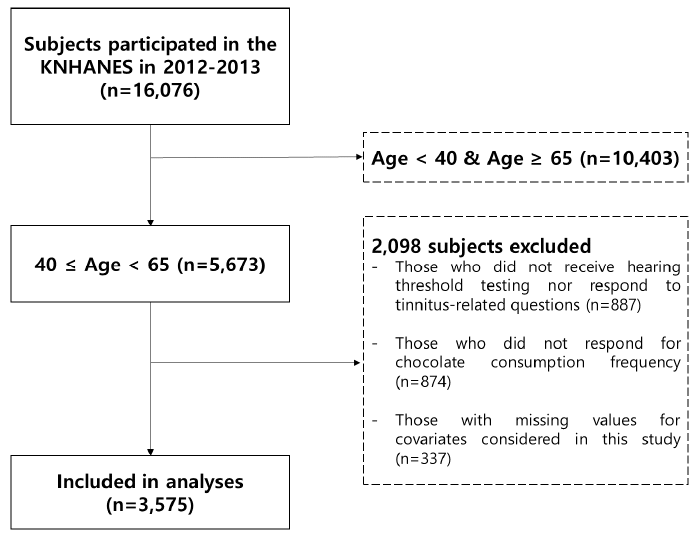
Figure 1. Schematic illustration of the selection of subjects.